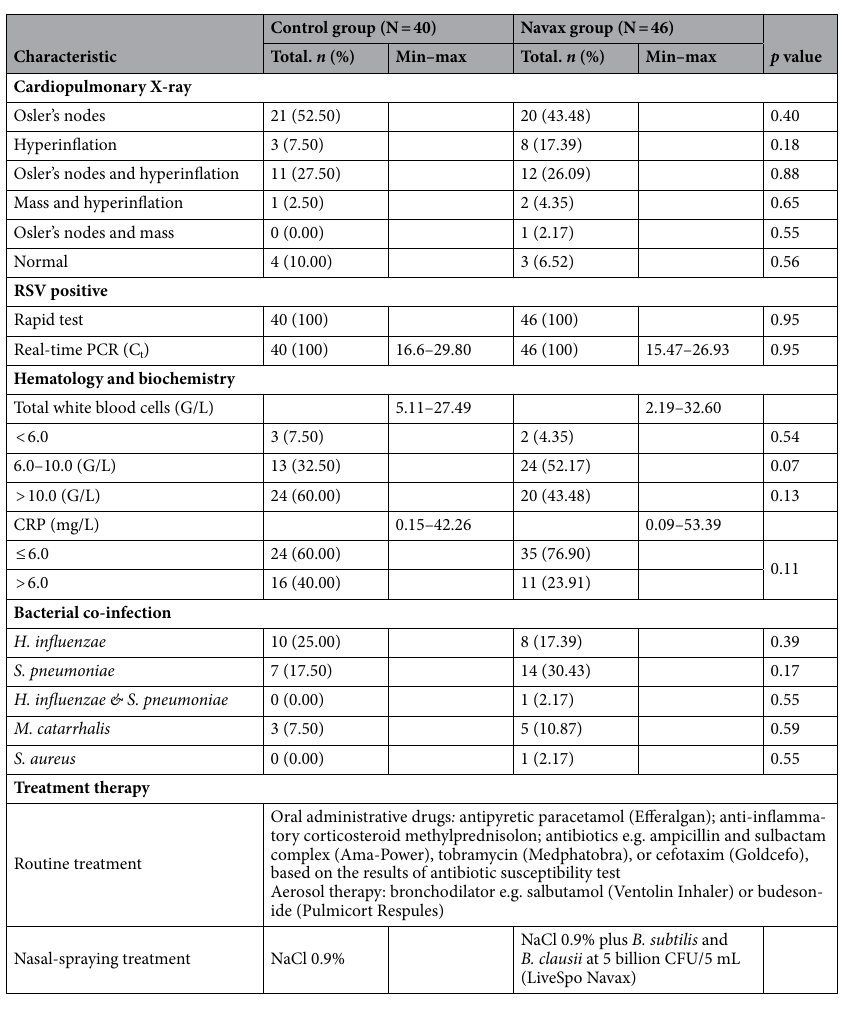
Table 2. Sub-clinical characteristics of RSV-infected children before